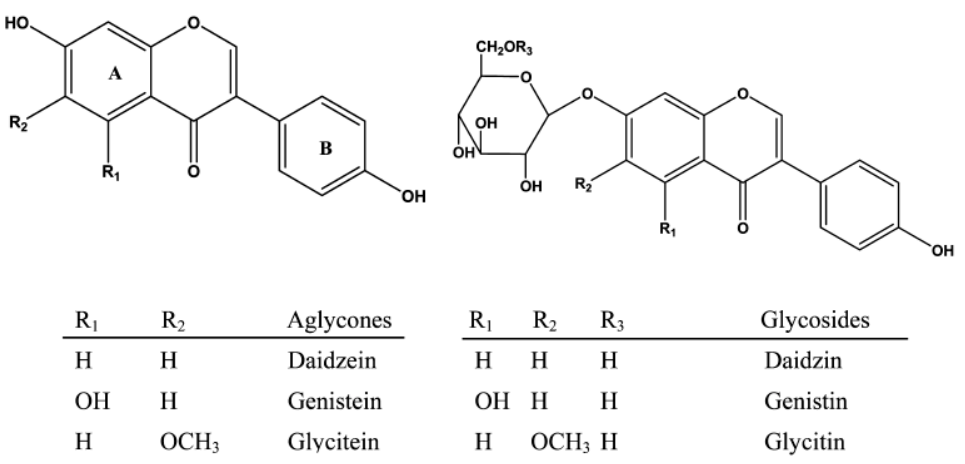
Figure 1. Chemical structures of isoflavones.